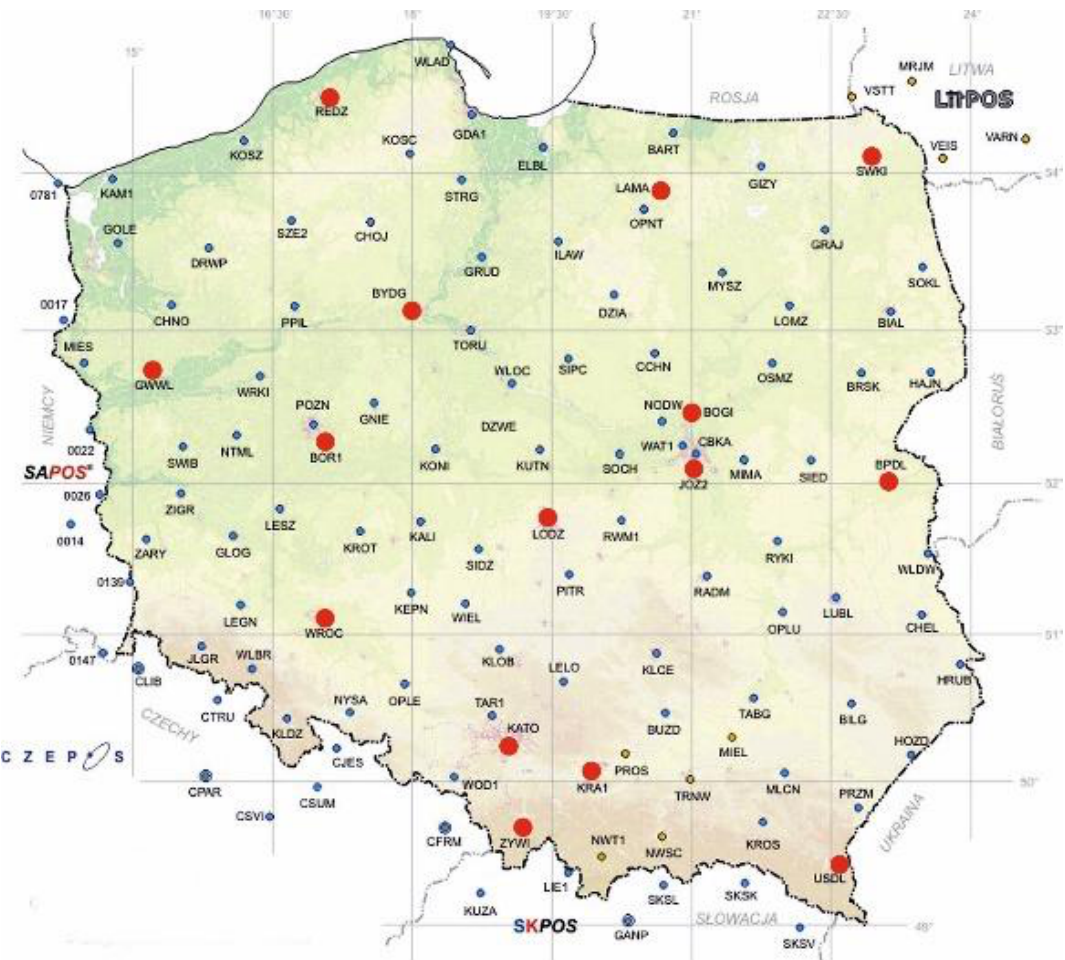
Figure 4. The distribution of the permanent ASG-EUPOS network stations in the territory of Poland. Stations marked with red circles are also EPN stations.